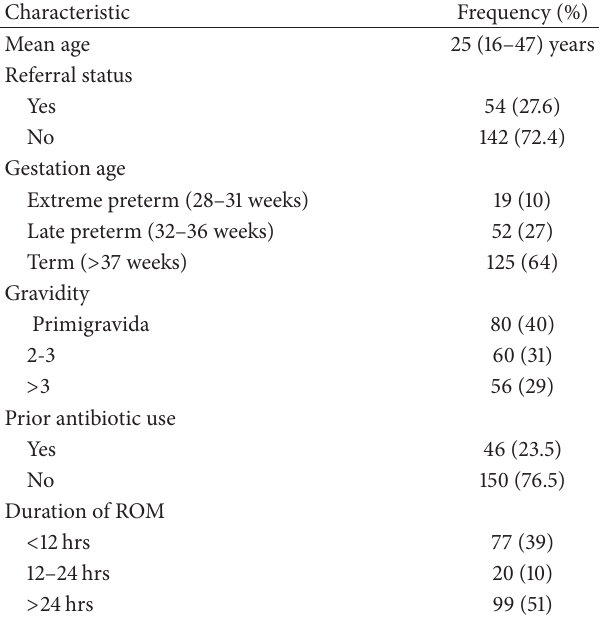
Table 1: Sociodemographic and clinical characteristics (𝑛 = 196).